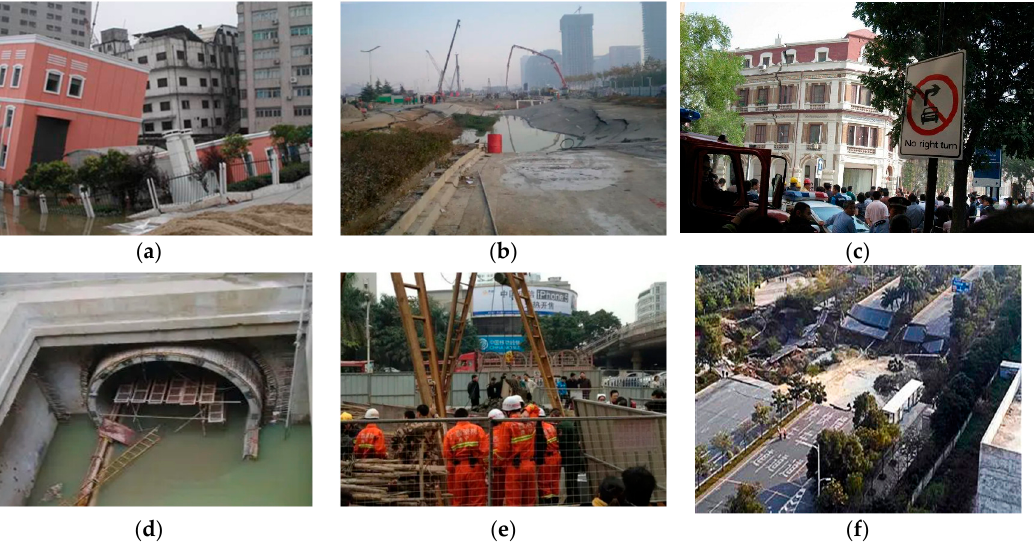
Figure 1. Safety incidents caused by water [7]. ( a ) Shanghai Metro Line 4 (2003). ( b ) Nanjing Metro Line 2 (2007). ( c ) Tianjin Metro Line 3 (2009). ( d ) Wuhan Metro Line 3 (2013). ( e ) Nanning Metro Line 1 (2014). ( f ) Foshan Metro Line 2 (2018).